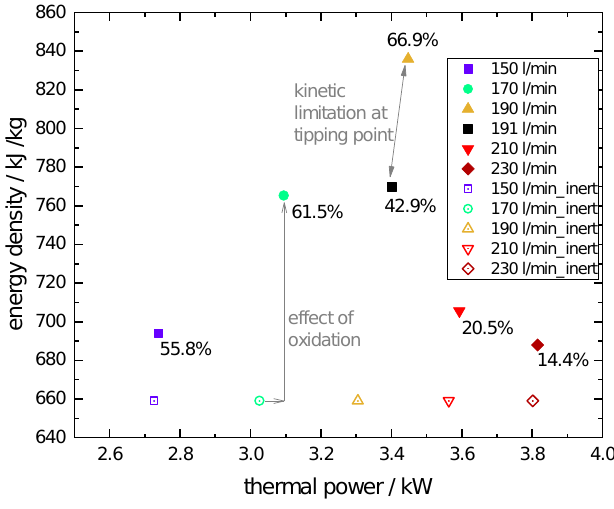
Figure 8. Thermal power and energy density of a moving bed of 4g/s with different gas flow rates ˙ V n . The numbers next to the full symbols represent the conversion (%) achieved in steady state operation. Empty symbols represent the Mn-Fe-oxide particles acting only as sensible thermal storage